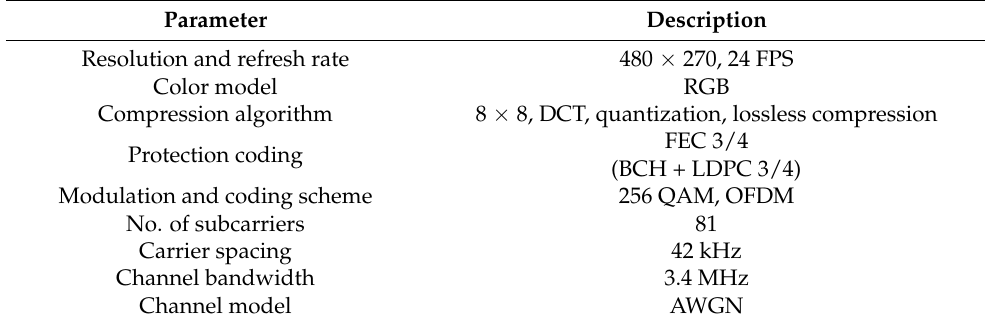
Table 1. Basic parameters of the simulated video transmission system.